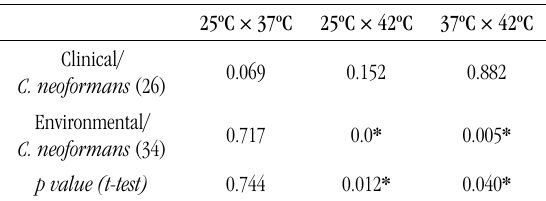
tABLE 4 – Statistical correlation between mean concentration of Cryptococcus neoformans isolates under thermotolerance and differences in test temperatures